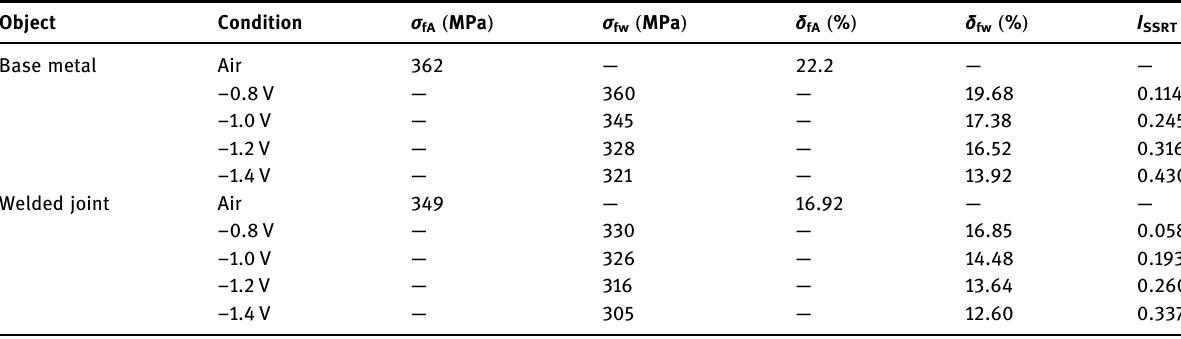
Table 3: Stress corrosion sensitivity index calculated values of each parameter